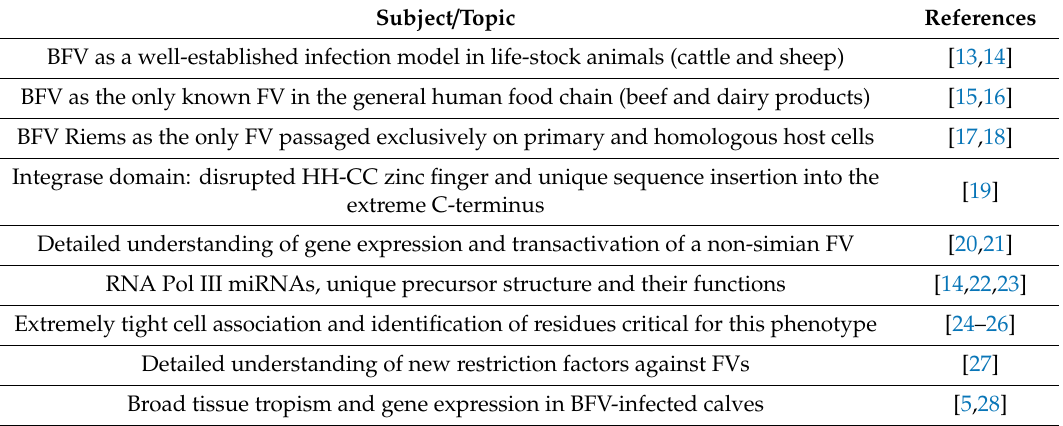
Table 1. Special features and novel insights that were gained from past and current work on Bovine Foamy